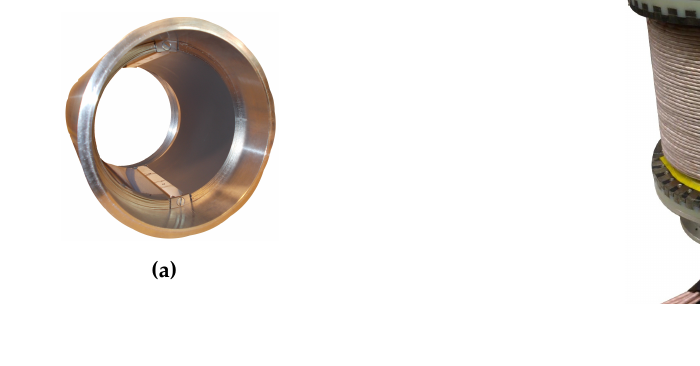
Figure 3. Photographs of rotor and stator of SRM prototype. ( a ) The assembled outer-rotor prototype, not including the central shaft. One half ferromagnetic and one half austenitic stainless steel; and ( b ) the three-phase stator with windings. The aluminum lid is on top, with a plastic plate separating it from the standing laminated c-shaped bits. The windings are wound around each of the three groups of c-shaped bits. The stator is hollow to allow for a shaft in the